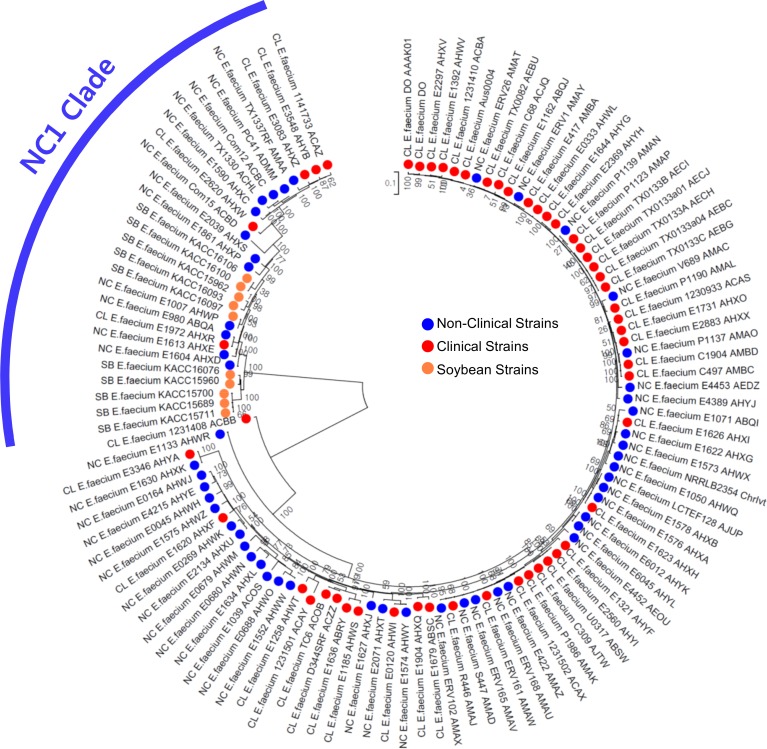
Evolutionary relationships of 113 strains based on 59,739 SNPs from 990 core genes.The optimal tree with the sum of branch length = 3.21 is shown. The tree is drawn to scale, with branch lengths in the same units as those of the evolutionary distances used to infer the phylogenetic tree. The evolutionary distances are in the units of the number of base substitutions per site.